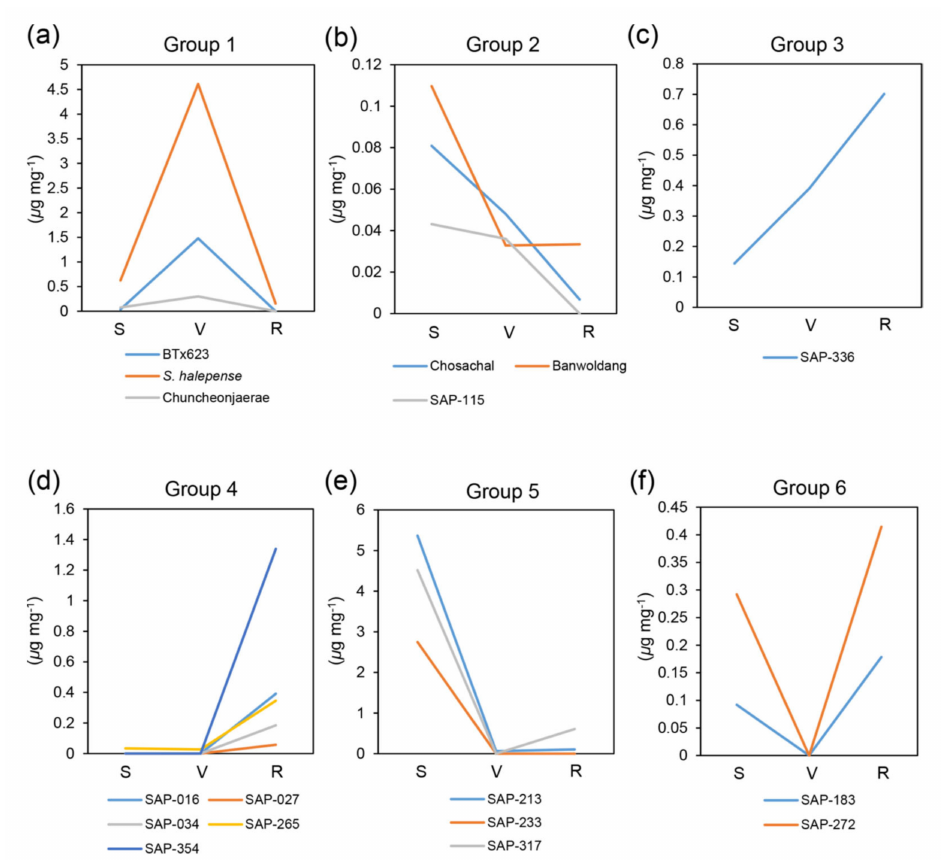
Figure 4. Grouping analysis of pHPAAc contents by di ff erent developmental stages. The pHPAAc 1. ( b ) Group 2. ( c ) Group 3. ( d ) Group 4. ( e ) Group 5. ( f ) Group 6. A separate graph showing